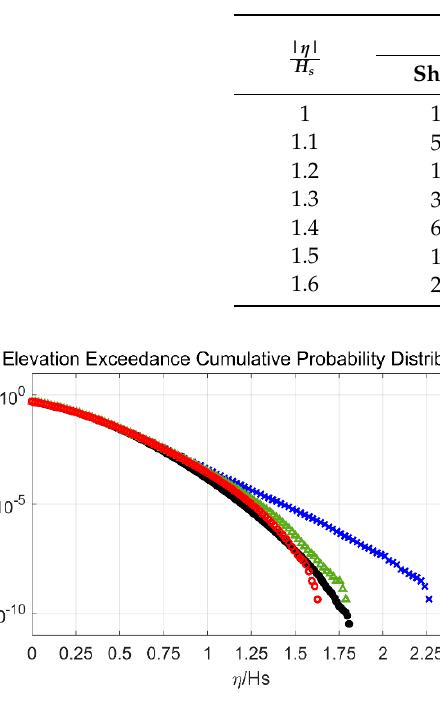
Table 4. Quantitative data of Elevation Exceedance for the four waves cases. Note that, comparing the short-crested waves with 1D long-crested waves, for η crested waves with U/C = 0.8 is, on average, a factor two higher, but for η short-crested waves becomes much higher.